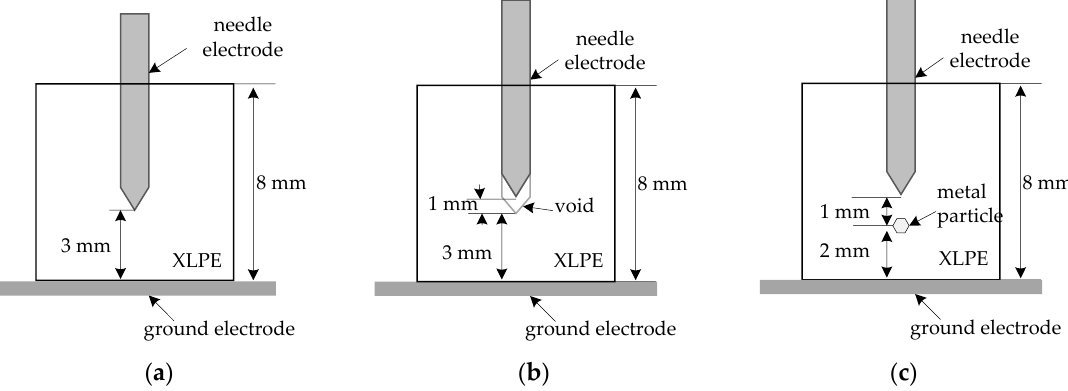
Figure 1. Artificial electric tree models: ( a ) tree model 1 was only needle electrode; ( b ) tree model 2 with void on needle electrode surface; ( c ) tree model 3 with metal particle between needle and ground electrode [18–20].